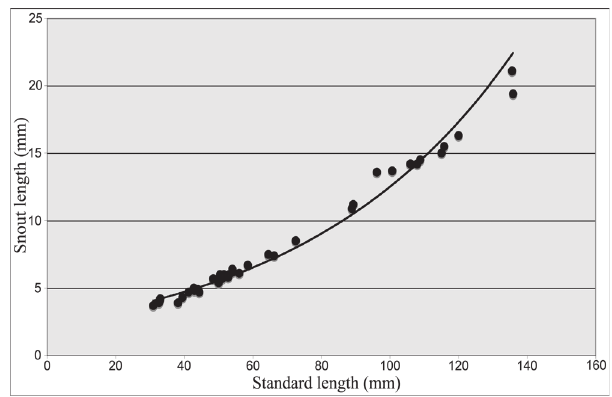
Fig. 8. Graph showing the ontogenetic elongation of the snout in Leporinus reticulatus .